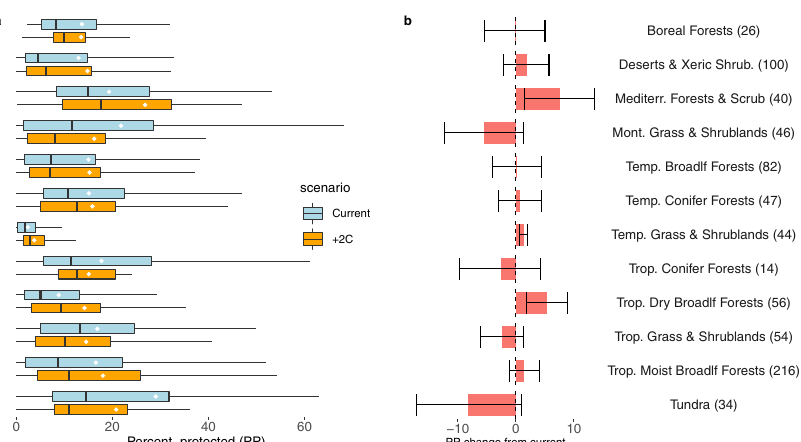
Fig. 4 Summary of biome-level protection status under current and + 2 o C conditions. a Current and projected future protection status by biome. White diamonds represent biome level means; colored boxes represent the interquartile range. b The mean change in percent protection ( Δ PP ) between current and projected future conditions. Error bars bound the 10th and 90th percentiles of values from a bootstrapped distribution of ecoregions within each biome. The number of ecoregions within each biome is shown parenthetically next to